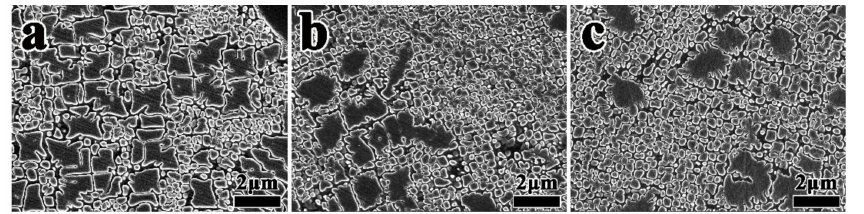
Figure 8. The γ ’ phase under isothermal heat treatment at the temperature of 1160 ◦ C with different soaking time: ( a ) 0 h; ( b ) 1 h; ( c ) 2 h.